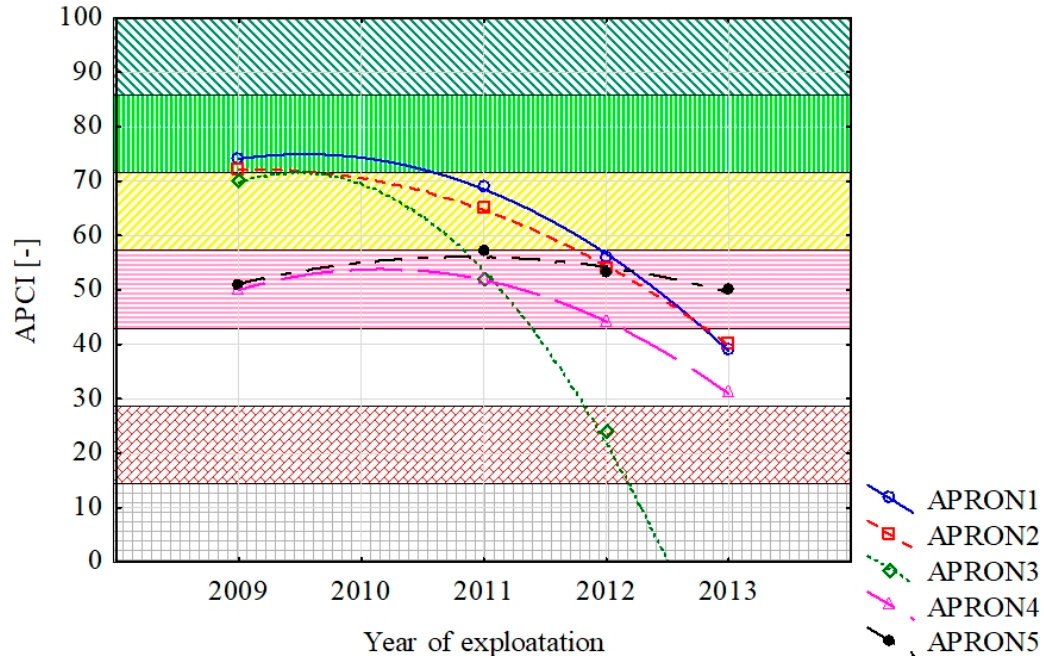
Figure 5. Example of Output Data using.